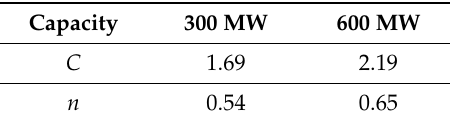
Table 1. The values of C and